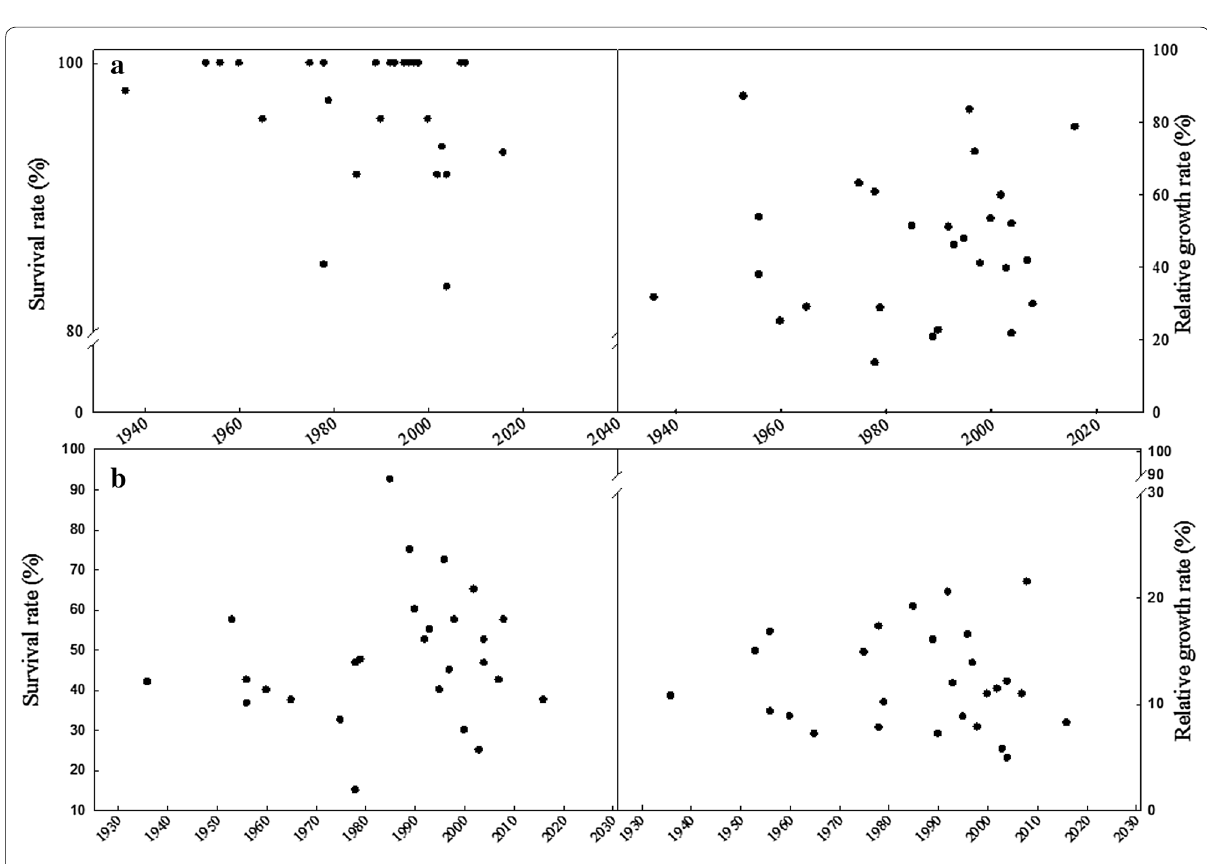
Fig. 6 Correlation of seedling survival rates and shoot relative growth rate (RGR) with years that varieties were released under the TIR48 ( a ) and TIR50 ( b ) treatment. Dots in the figure indicate varieties tested in this study and there are 27